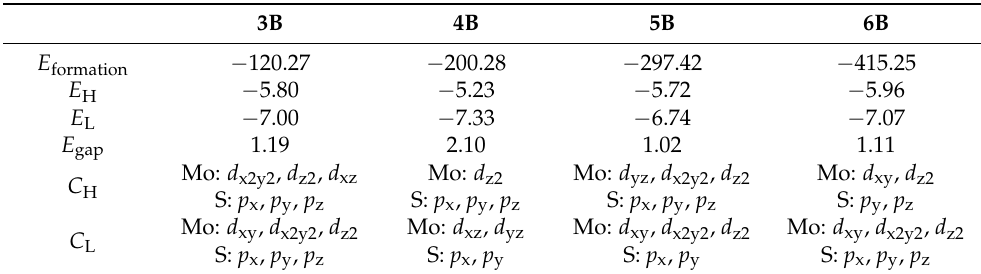
Table 3. Formation energy E formation (eV), energy of HOMO E H (eV), energy of LUMO E L (eV), energy gap between HOMO and LUMO E gap (eV), as well as orbital composition of HOMO C H and LUMO C L of 3C , 4C , 5C , and 6C . 3C 4C 5C 6C E formation − 137.42